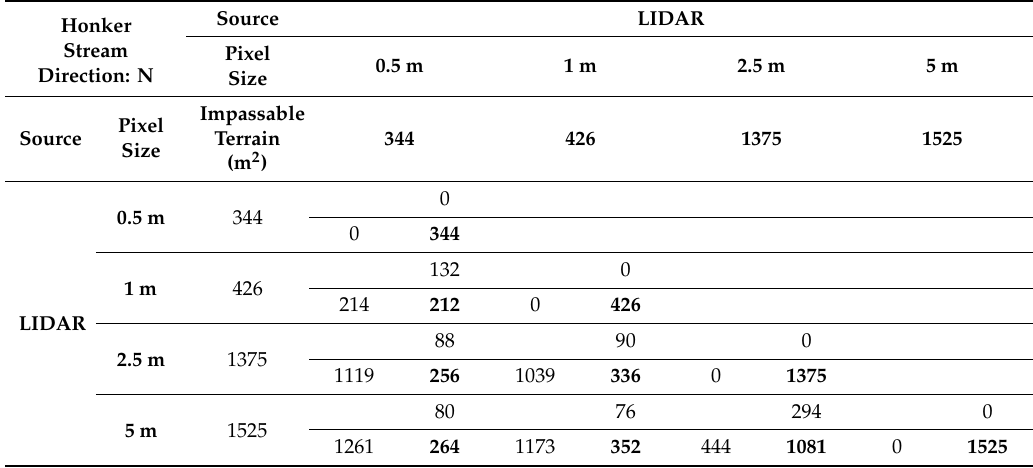
Table 10. Intersection between impassable areas of the Honker moving northward in stream terrain (LIDAR data).